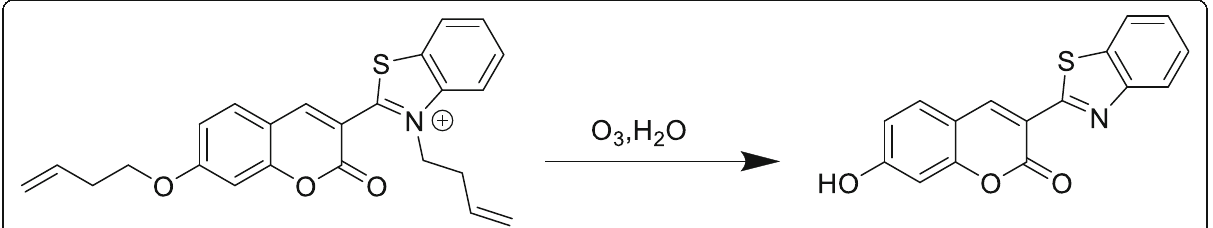
Fig. 2 Comparison of the structure of probe BCT and O 3 before and after the